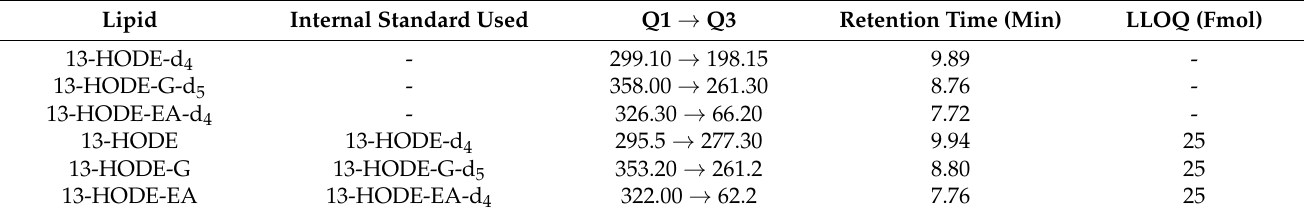
Table 1. LC-MS quantification of 15-LO